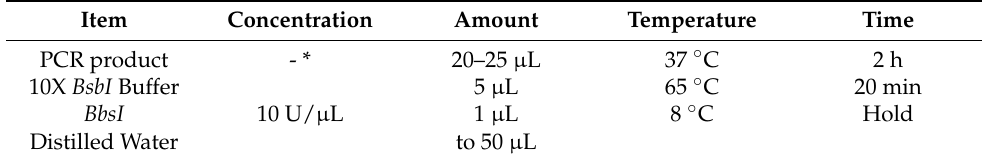
Table 12. Components of insert polymer digestion and thermal conditions.